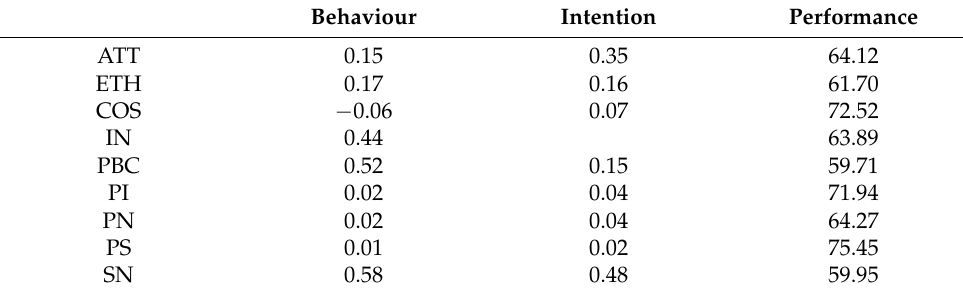
Table 5. Importance–Performance Map Analysis